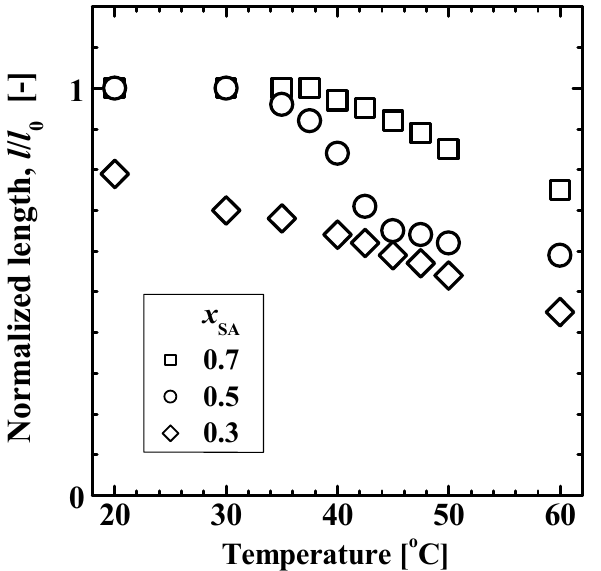
Figure 4. Normalized length, l / l 0 , of cylinder-shaped poly(SA- co -MPGA) hydrogels with x SA = 0.3, 0.5, and 0.7 as a function of temperature. l 0 is the initial length at 20 °C. l is the hydrogel length loaded with weight (36 g) at a given temperature.